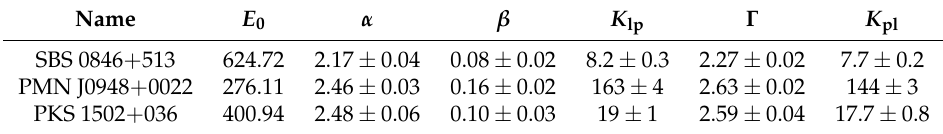
Table 1. γ -ray spectral parameters (log-parabola and power-law models) for the three considered sources according to the Fourth Fermi-LAT Catalog [14]. E 0 is the pivot energy [MeV]; α is the photon index of the log-parabola model; β is the curvature; K lp is the normalization of the log-parabola